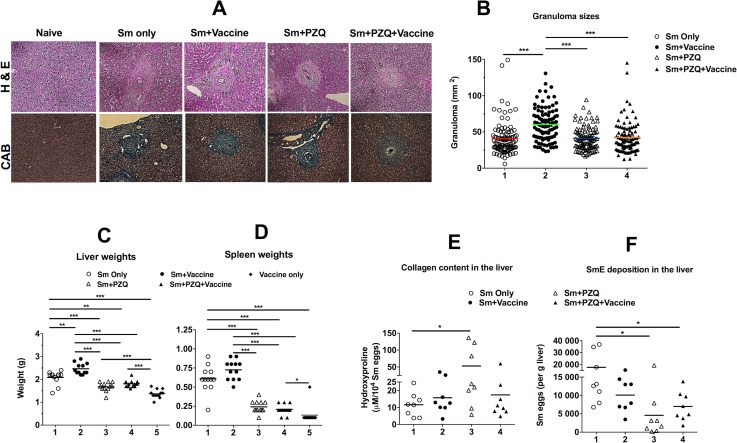
Analysis of livers and spleens of mice after vaccination with a DNA+MVA vaccine regimen.Groups of mice were infected with 30–35 Sm cercariae. Some groups were treated twice with PZQ after 8.5 weeks post infection. Vaccination with a DNA+MVA vaccine regimen was performed as shown in Table 1. Spleens and livers were harvested 12 days after last vaccination, weighed and prepared for various analyses. (A): Representative histological micrographs showing liver granulomas after staining with either H&E or CAB; (B): Granuloma sizes; (C) Liver weights; (D): Spleen weights; (E): hydroxyproline content and (F): Number of eggs per gram of liver. For Figs B-D, the results represent 3 independent experiments. For Figs E and F, the data is representative of 2 independent experiments. Means are shown as horizontal bars. Statistical analysis was performed using unpaired, two-tailed t-test analysis followed by FDR for multiple comparisons. (*: p>0.05; **: p<0.01; ***: p<0.001).